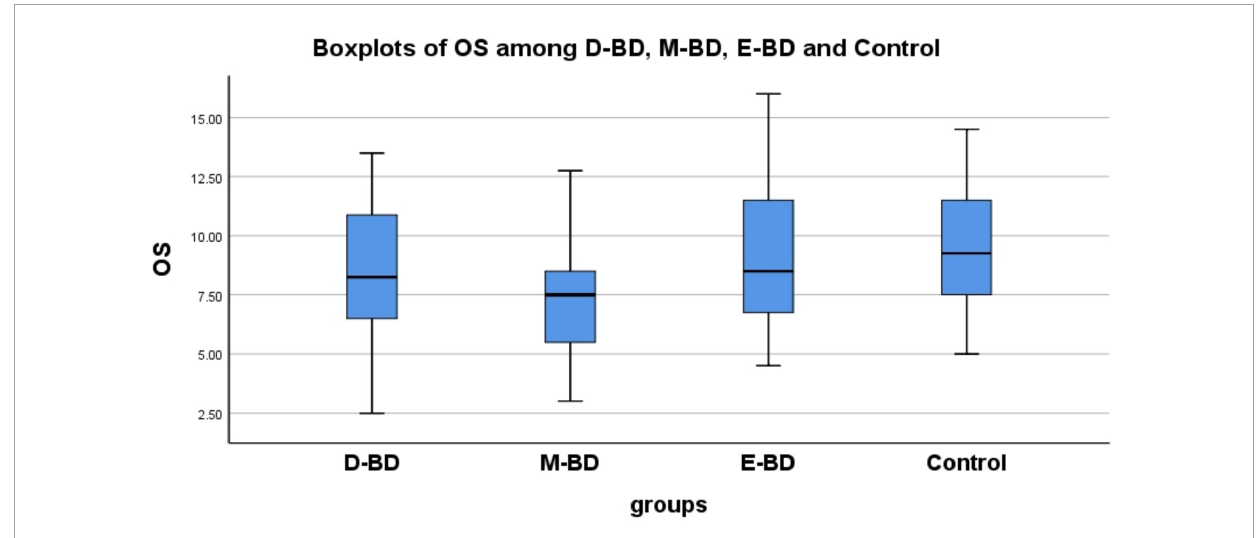
FIGURE2 There are statistically significant differences in OS between D-BD, M-BD, and control ( P = 0.036, P < 0.001) and between M-BD and E-BD ( P = 0.001). OS, olfactory sensitivity; BD, bipolar disorder; D-BD, depressive bipolar disorder; M-BD, manic bipolar disorder; E-BD, euthymic bipolar